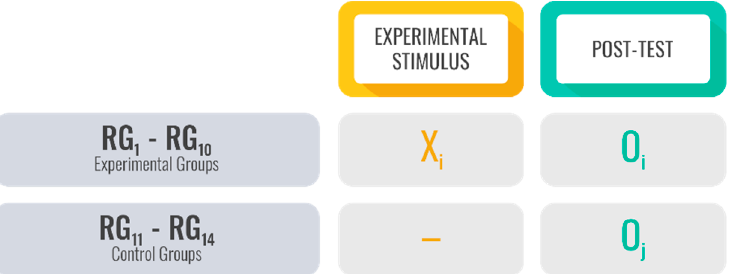
Figure 6. Experimental design.